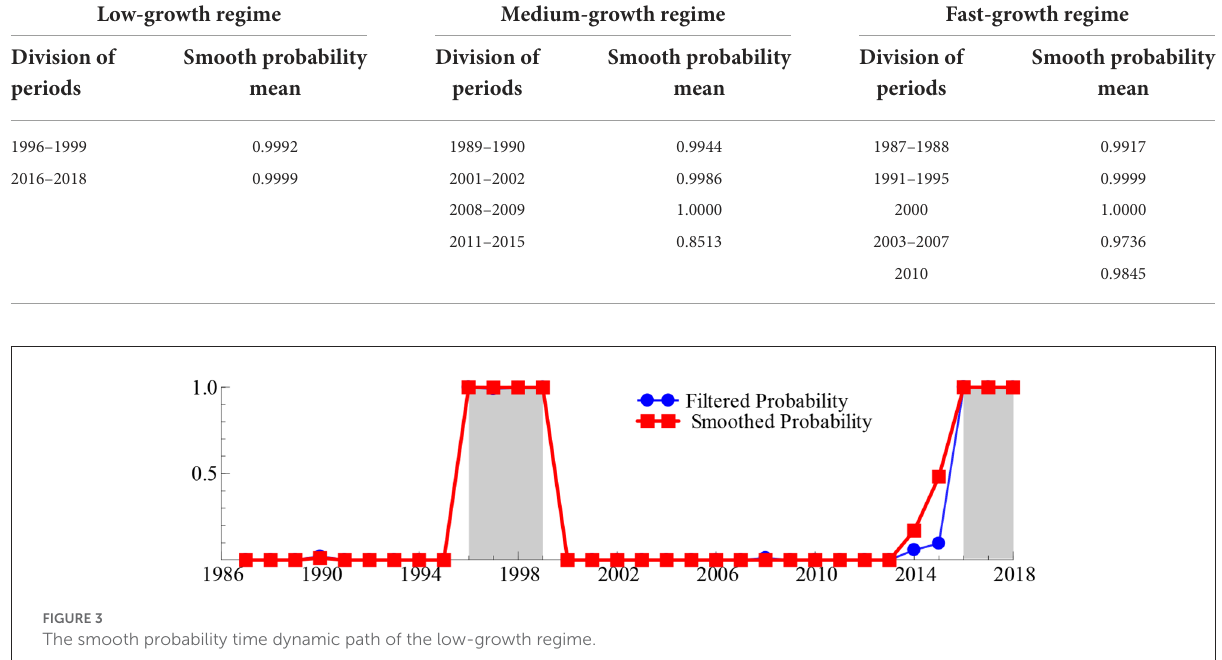
TABLE 2 Partition and smoothing probability means of the SO 2t − GDP t system.